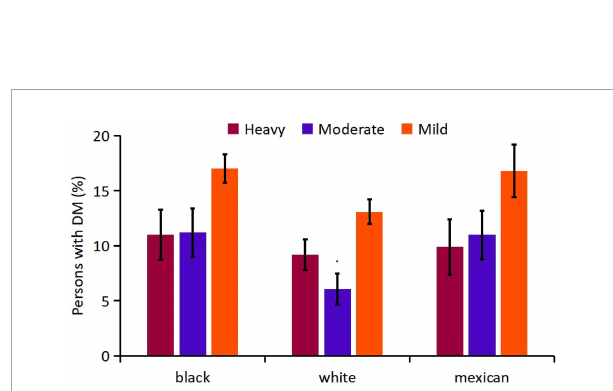
FIGURE 6 Analysis on the Mean percentage of participants with DM in smokers and nonsmokers of different races. ** P<0.01 vs Smokers